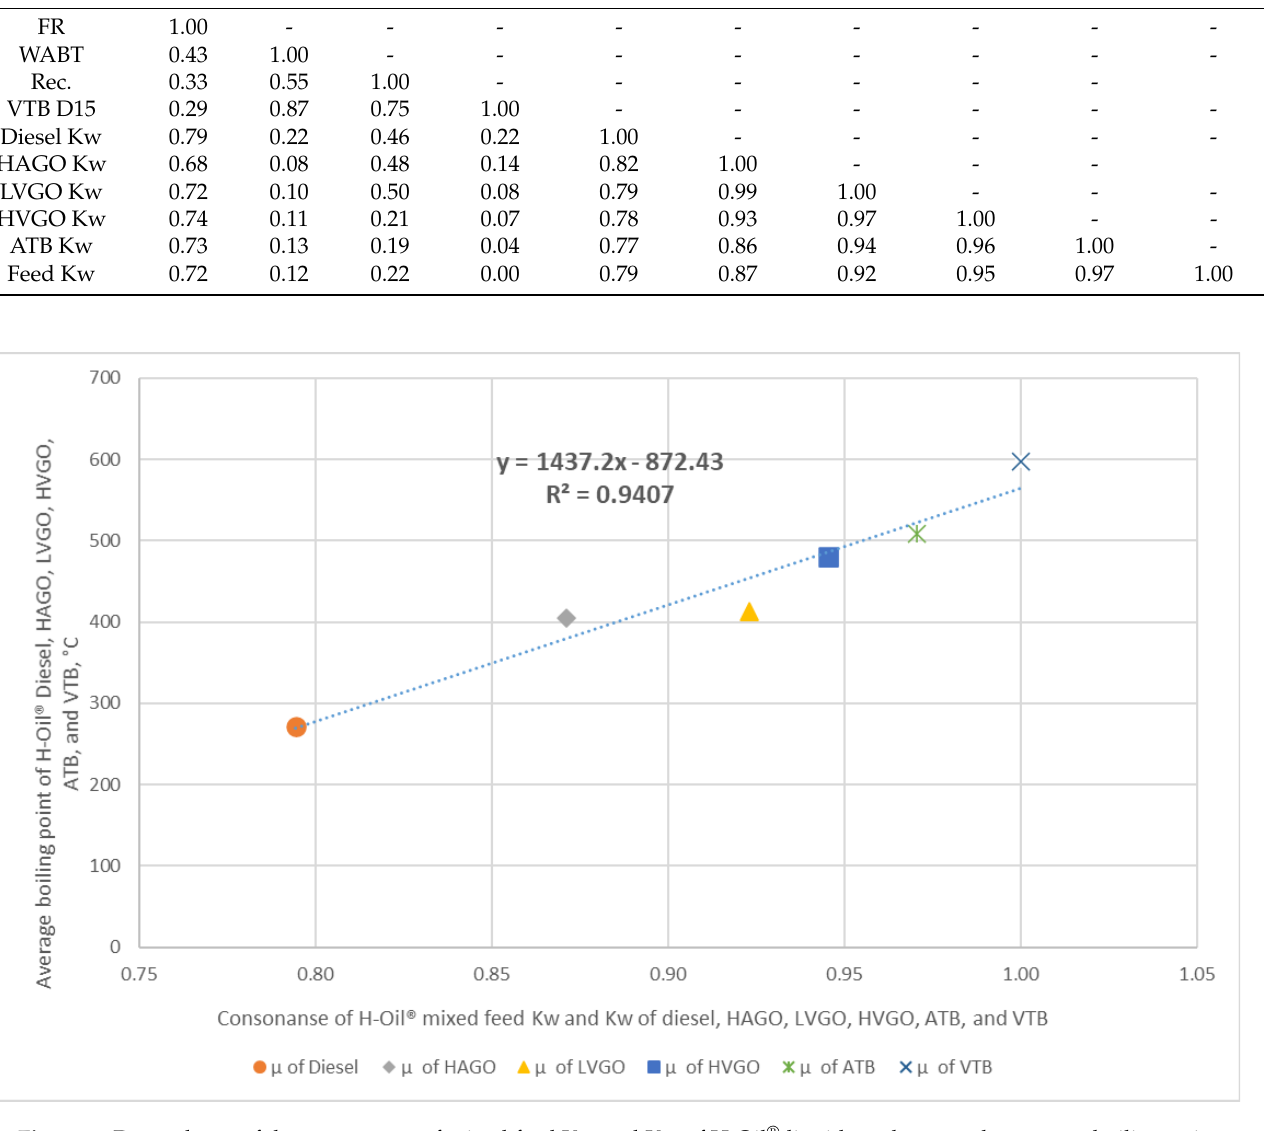
Figure 3. Kw for the blended SRVROs, the mixture SRVRO-FCC SLO, and for the mixed feed. It is evident from the data in Figure 3 that the Kw of the mixed H-Oil ® feed gradually decreases from Case 1 to Case 36. The blended SRVROs Kw for the studied 36 cases varied between 11.90 (Kw of Urals crude oil, the main crude oil for LNB refinery for this study) and 11.22 (Kw of the crude oil blend 41%Urals/34.5%Kirkuk/24.5%El Bouri; Case 32). The lowest Kw of the mixture blended SRVROs—FCC SLO was that of Case 32 and it was 10.97. The lowest Kw of the mixed H-Oil ® feed was that of case 32, and it was 10.07. As apparent from the data in Figure 4 the sum of the FCC SLO and the recycle of PBFO can